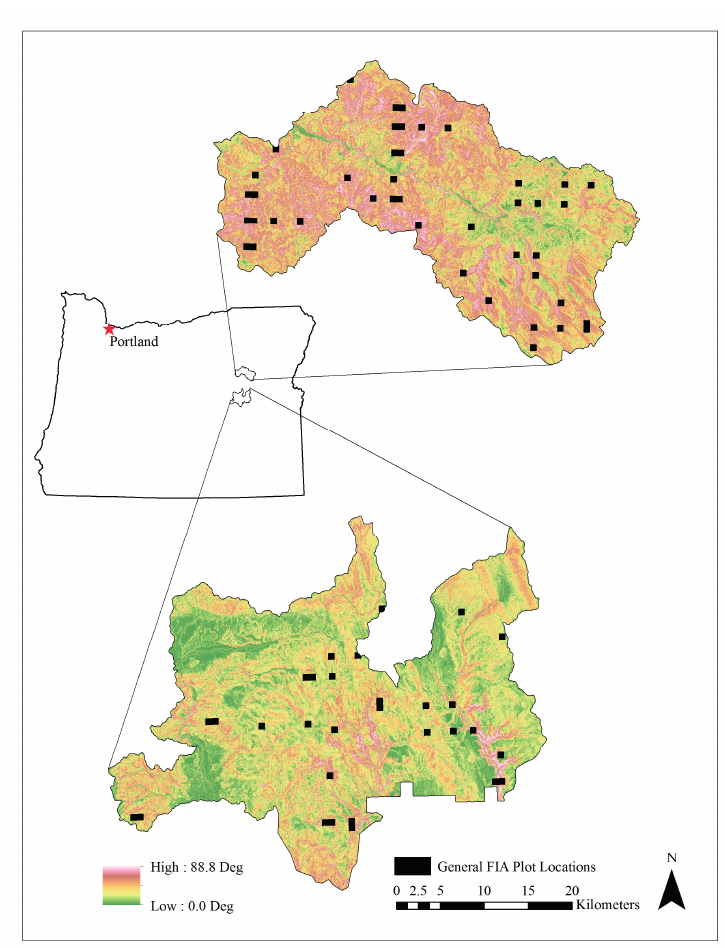
Figure 1. Malheur National Forest study area in eastern Oregon with slope depicted in degrees. Black squares represent locations of selected Forest Inventory and Analysis plots field-visited between 2007 and 2009. Actual plot locations have been obscured due to confidentiality